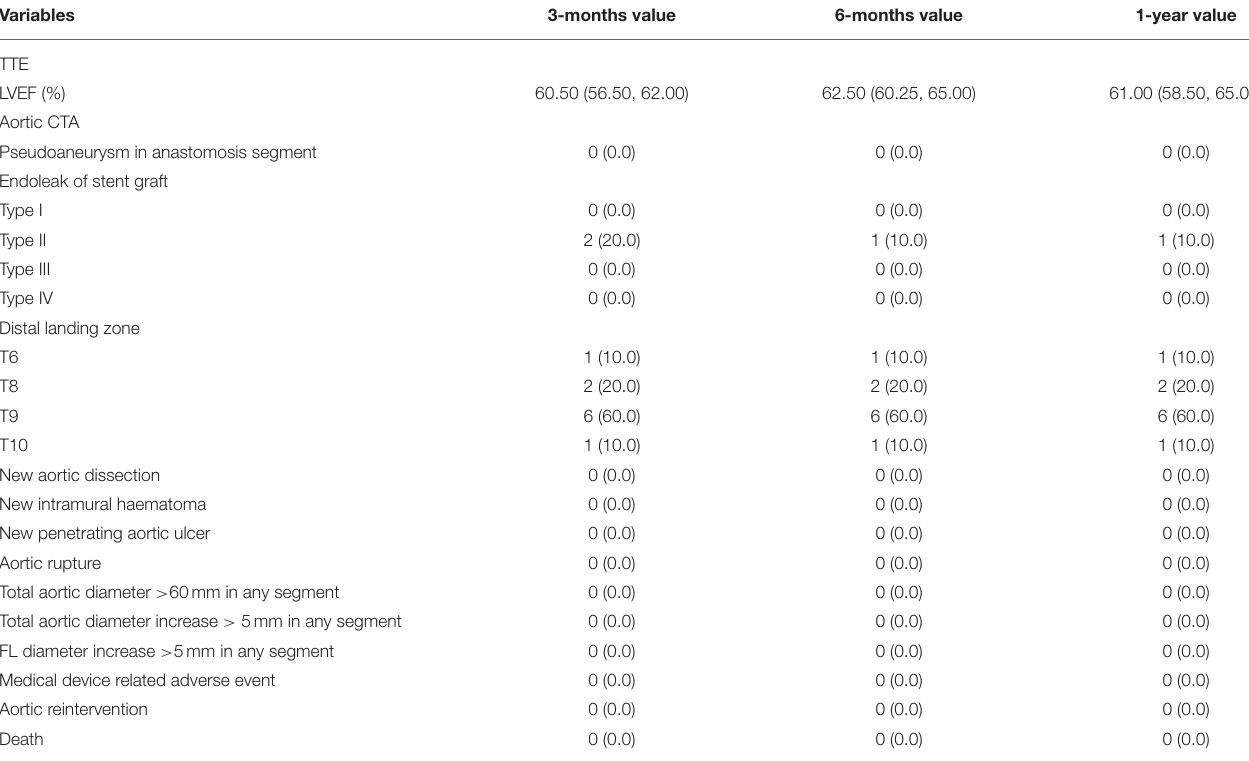
TABLE 6 | Follow-up outcomes.